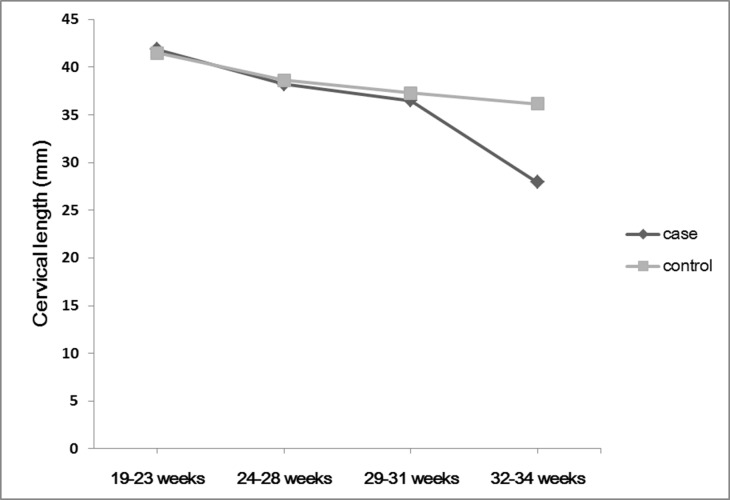
Serial changes in cervical length from 19 to 34 weeks comparing two groups.The black line represents the cervical length of women in the emergent cesarean delivery group, and the gray line represents that of the elective cesarean group.